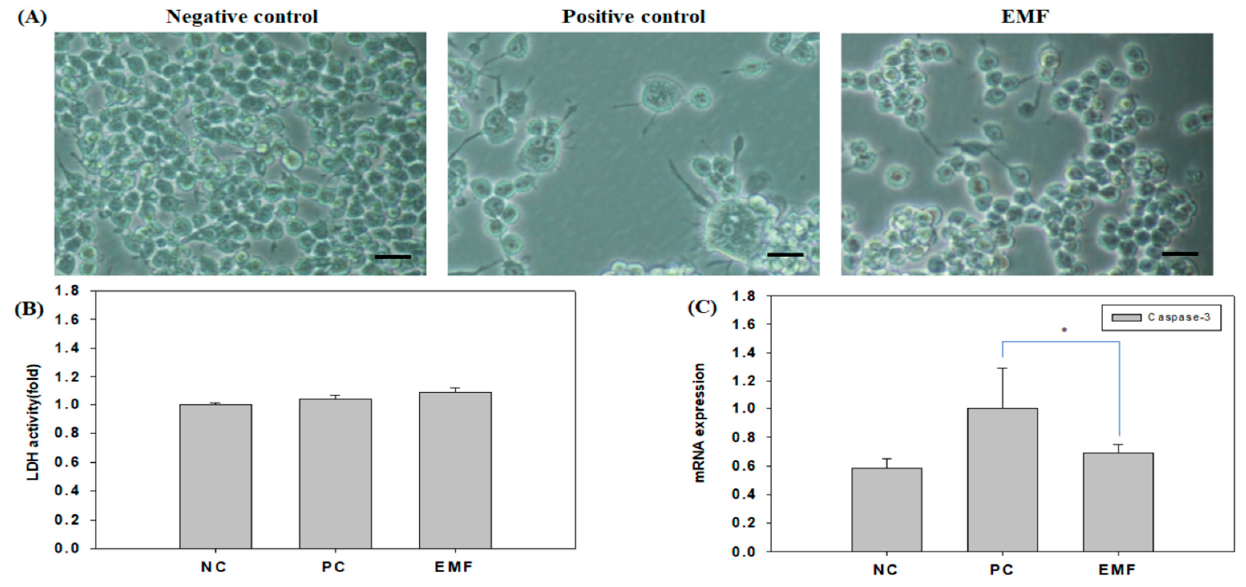
Figure 1. EMF exposure does not induce cellular damage. ( A ) Images of Raw 264.7 cells after EMF (10 G, 40 Hz) exposure. Scale bar, 100 μ m. ( B ) Cellular stress (measured by LDH assay) and (C ) apoptosis (measured by Caspase-3 expression) in Raw 264.7 cells after 4 days of EMF exposure. EMF, electromagnetic field; LDH, lactate dehydrogenase. Negative control (NC), cells grown in growth media (undifferentiated); positive control (PC), cells grown in differentiation media (with RANKL); EMF, cells grown in differentiation media (with RANKL) with EMF exposure. The symbol * indicate a significant difference with p < 0.05.